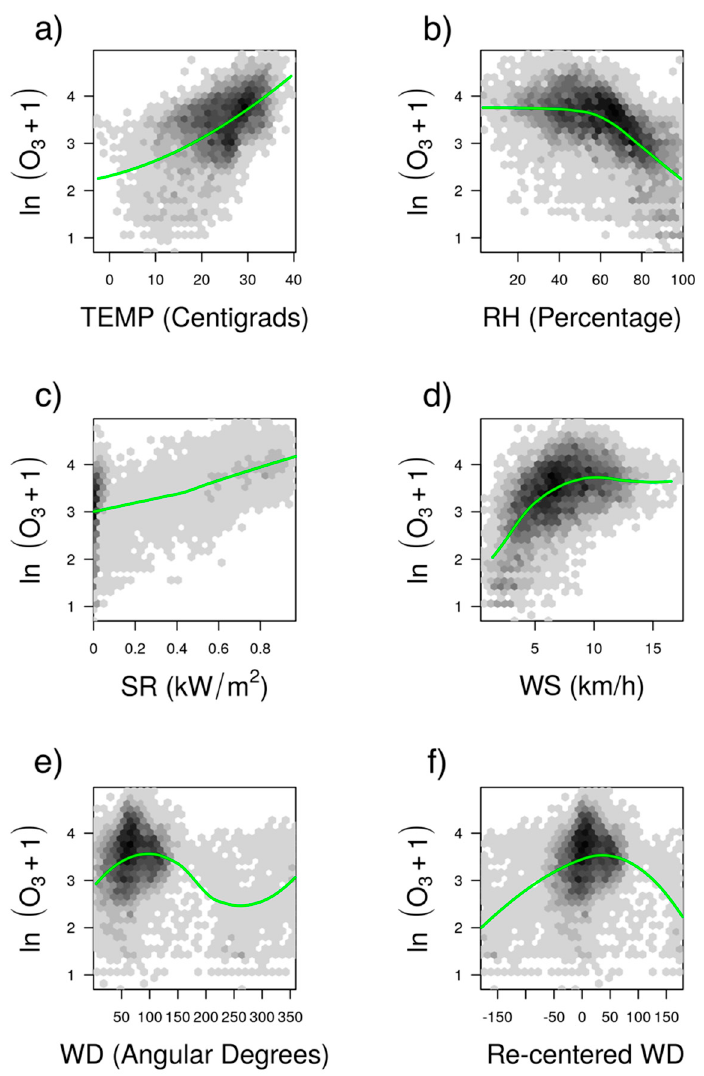
Figure 2. Relationship between natural logarithm of O 3 and meteorological variables for the OBI site: ( a ) TEMP, ( b ) RH, ( c ) SR, ( d ) WS, ( e ) WD in angular degrees, and ( f ) re-centered WD. Observe the non-linear nature of the relationships. Simple natural logarithmic, polynomial and inverse transformations were used to achieve linearity. A re-centering of angular wind direction around 60 degrees was used followed by measuring the absolute distances from this new center. Table 6. Transformations of meteorological representatives except for angular wind direction.